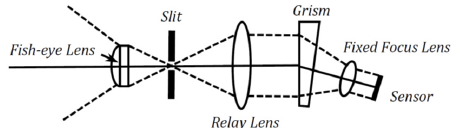
Figure 1. Auroral spectrograph (ASG) equipped at Zhongshan Station (ZHS).